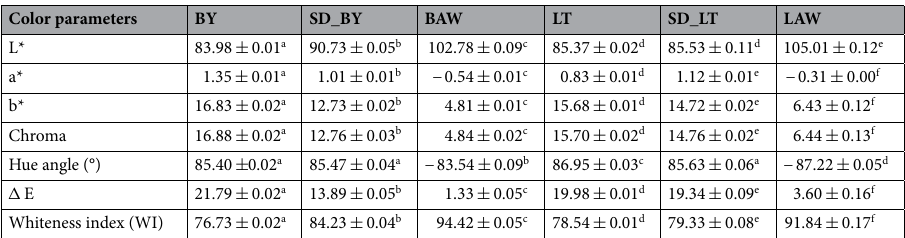
Table 2. Color parameters of millet flour and spray dried powder samples. Means having different letters as superscripts within the same row differ significantly (n = 5) at p < 0.05. Color parameters of the powder samples. BY: plain Barnyard millet flour; LT: plain Little millet flour; SD_BY: spray dried Barnyard millet soluble fraction; SD_LT: spray dried Little millet soluble fraction; BAW: 25% w/v Barnyard millet + acid whey; LAW: 25% w/v Little millet + acid